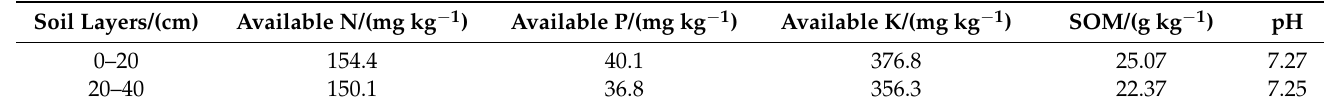
Figure 1. Temperature and rainfall. Table 1. Basic fertility of 0–40 cm soil in the experimental Table 1. Basic fertility of 0–40 cm soil in the experimental field.